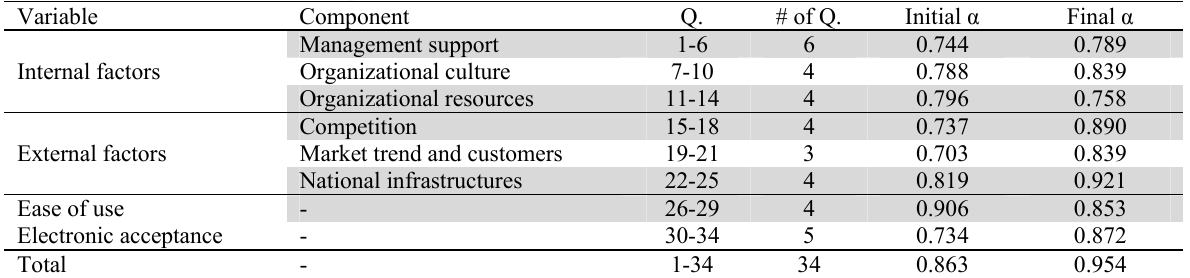
The summary of Cronbach alpha